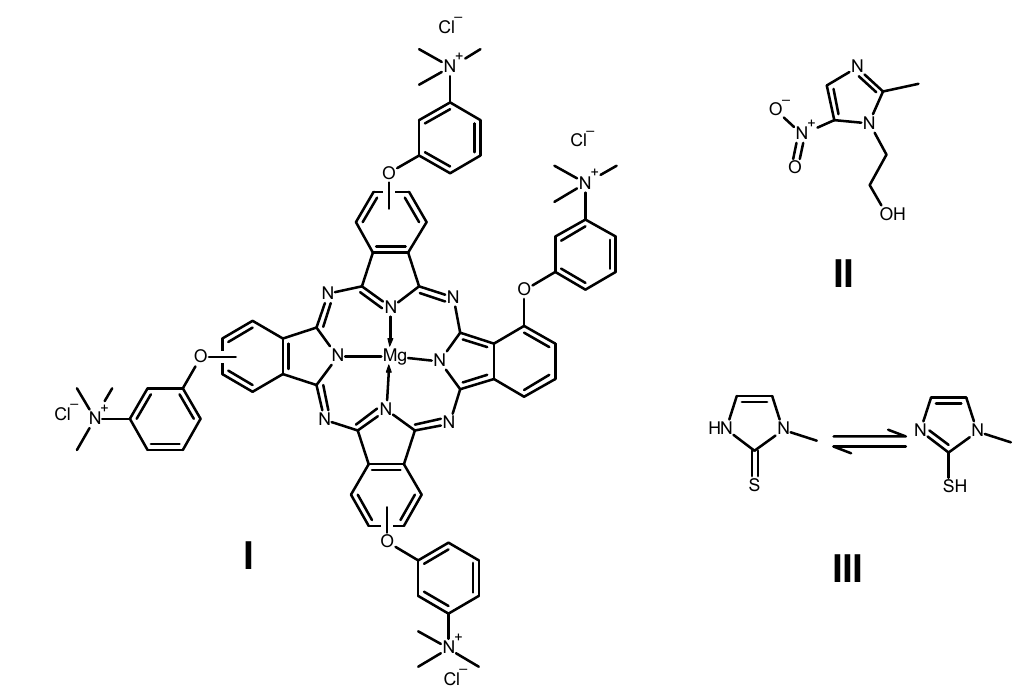
Figure 1. Structures of RLP068 ( I ), metronidazole ( II ) and methamizole ( III ). Imidazole belongs to azole heterocyclic compounds, characterized by two nitrogen atoms present at positions 1 and 3. Compounds containing the imidazole group have been interesting as new potential drugs in the treatment of many diseases. They have a broad spectrum of biological activity: anti-inflammatory, analgesic, antioxidant, antiulcer, antidiabetic and anticancer. However, one of the most interesting properties of imidazole derivatives is their antibacterial activity [25]. Currently, there are registered several an- timicrobials containing an imidazole ring in their structure: Ketoconazole, Metronidazole, Ornidazole, Azomycin, Oxiconazole and Miconazole. The mechanism of action of